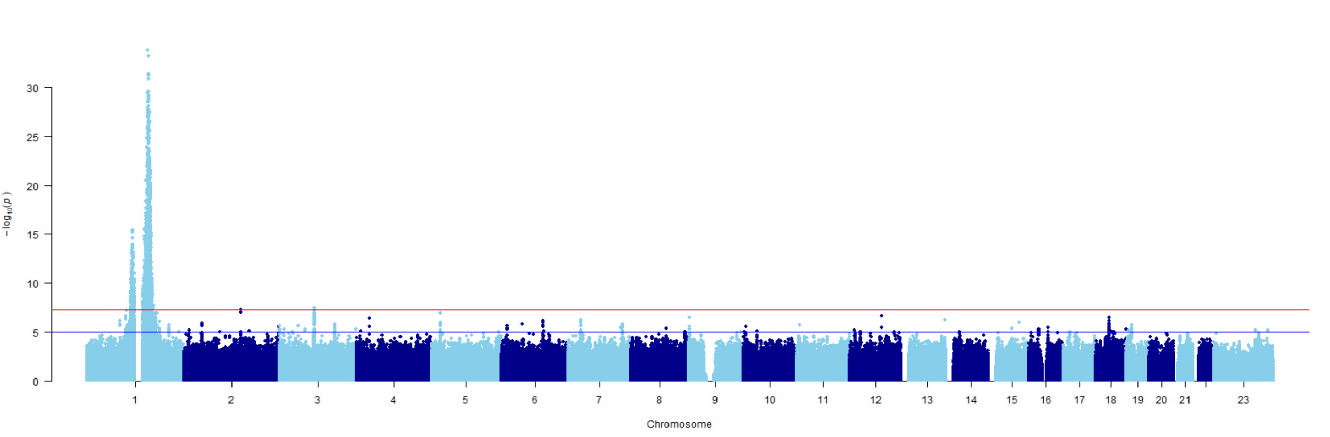
Fig 1. Manhattan plot for discovery GWAS for BEN: The REGARDS